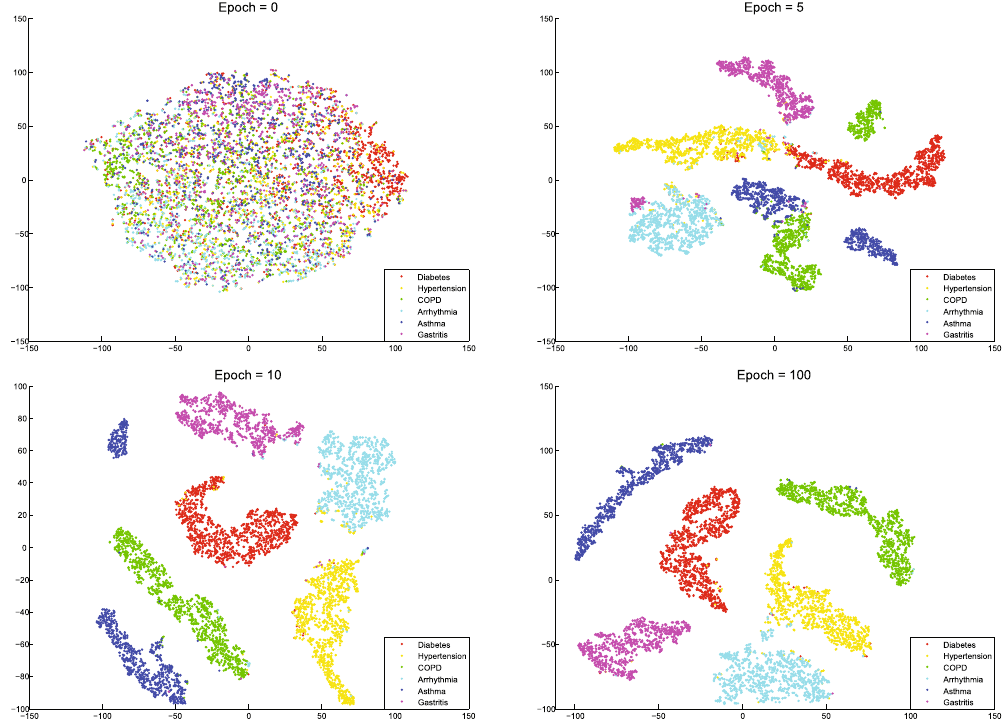
Figure 4. The change of feature space with the training process. In this feature space, each point represents an electronic medical record and different colors indicate different diseases. At the beginning of training (Epoch = 0), since the model parameters are randomly initialized, all the electronic medical records in the feature space are randomly distributed and indivisible. After 5 epoch, electronic medical records of different diseases began to have a trend of separation. After 10 epoch, the electronic medical records of all kinds of diseases have been separated, except for some areas and the edge of each category. When the training reaches 100 epoch, we can clearly see that the samples of each disease have been completely separated, and the electronic medical records of the same disease are also gathered